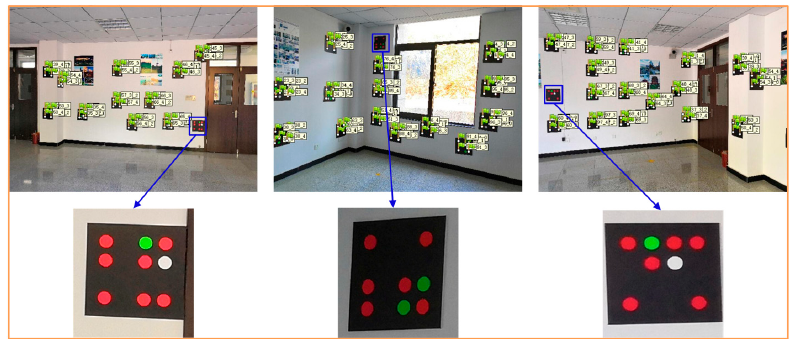
Figure 9. Identified wrong color encoded targets.